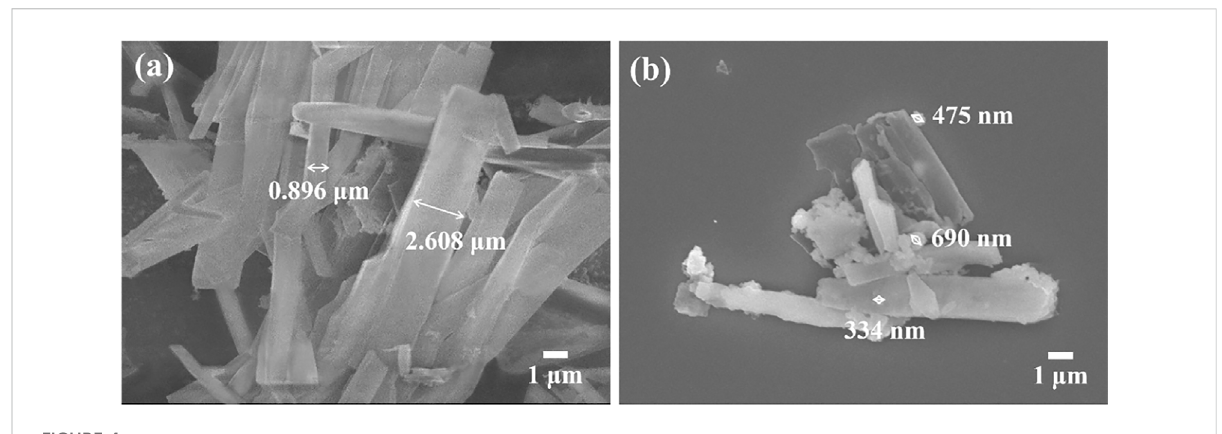
FIGURE 4 SEM images of (A) g-C 3 N 4 -N 3 and (B) PPor1-g-C 3 N 4